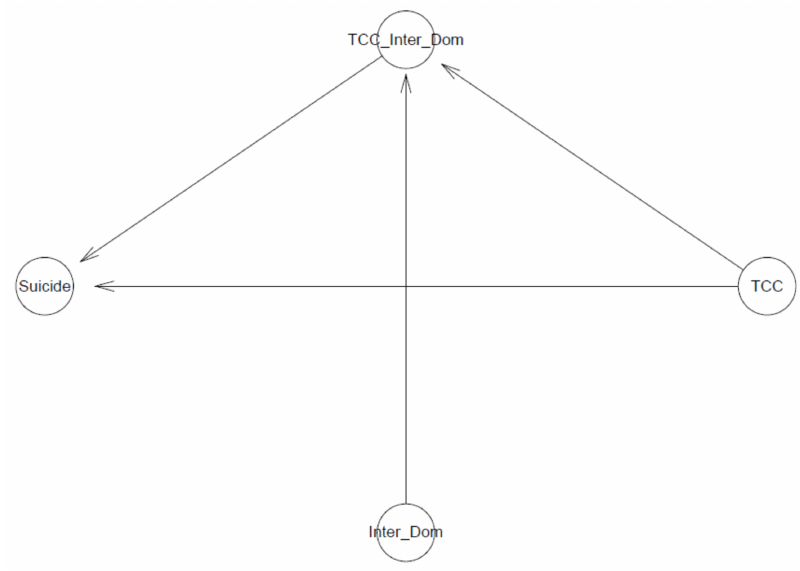
Figure 2. Model 1 (cid:48) s logical network.